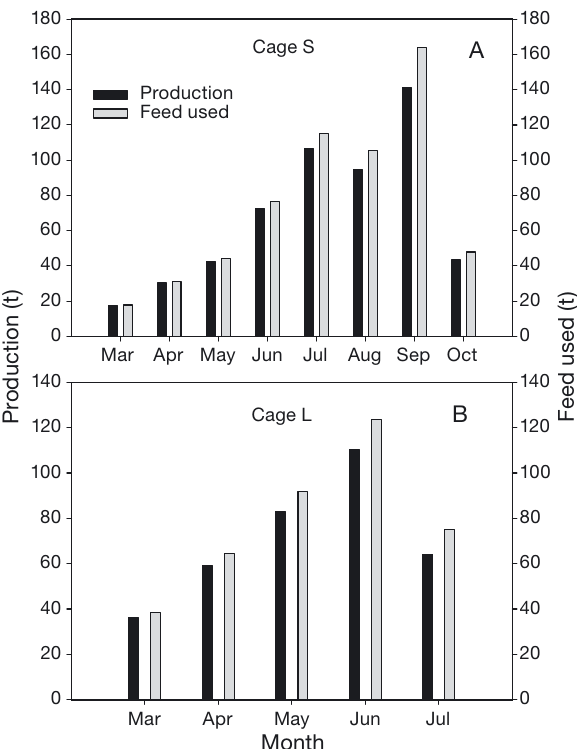
Fig. 1. Feed used (dry weight) and fish produced (wet weight) in 2 salmon cages − (A) Cage S and (b) Cage L − in Badstuvika during the experimental periods in 2009. Feed used and production values were provided by the fish farm in Badstuvika, fish were slaughtered in July in Cage S and in October in Cage